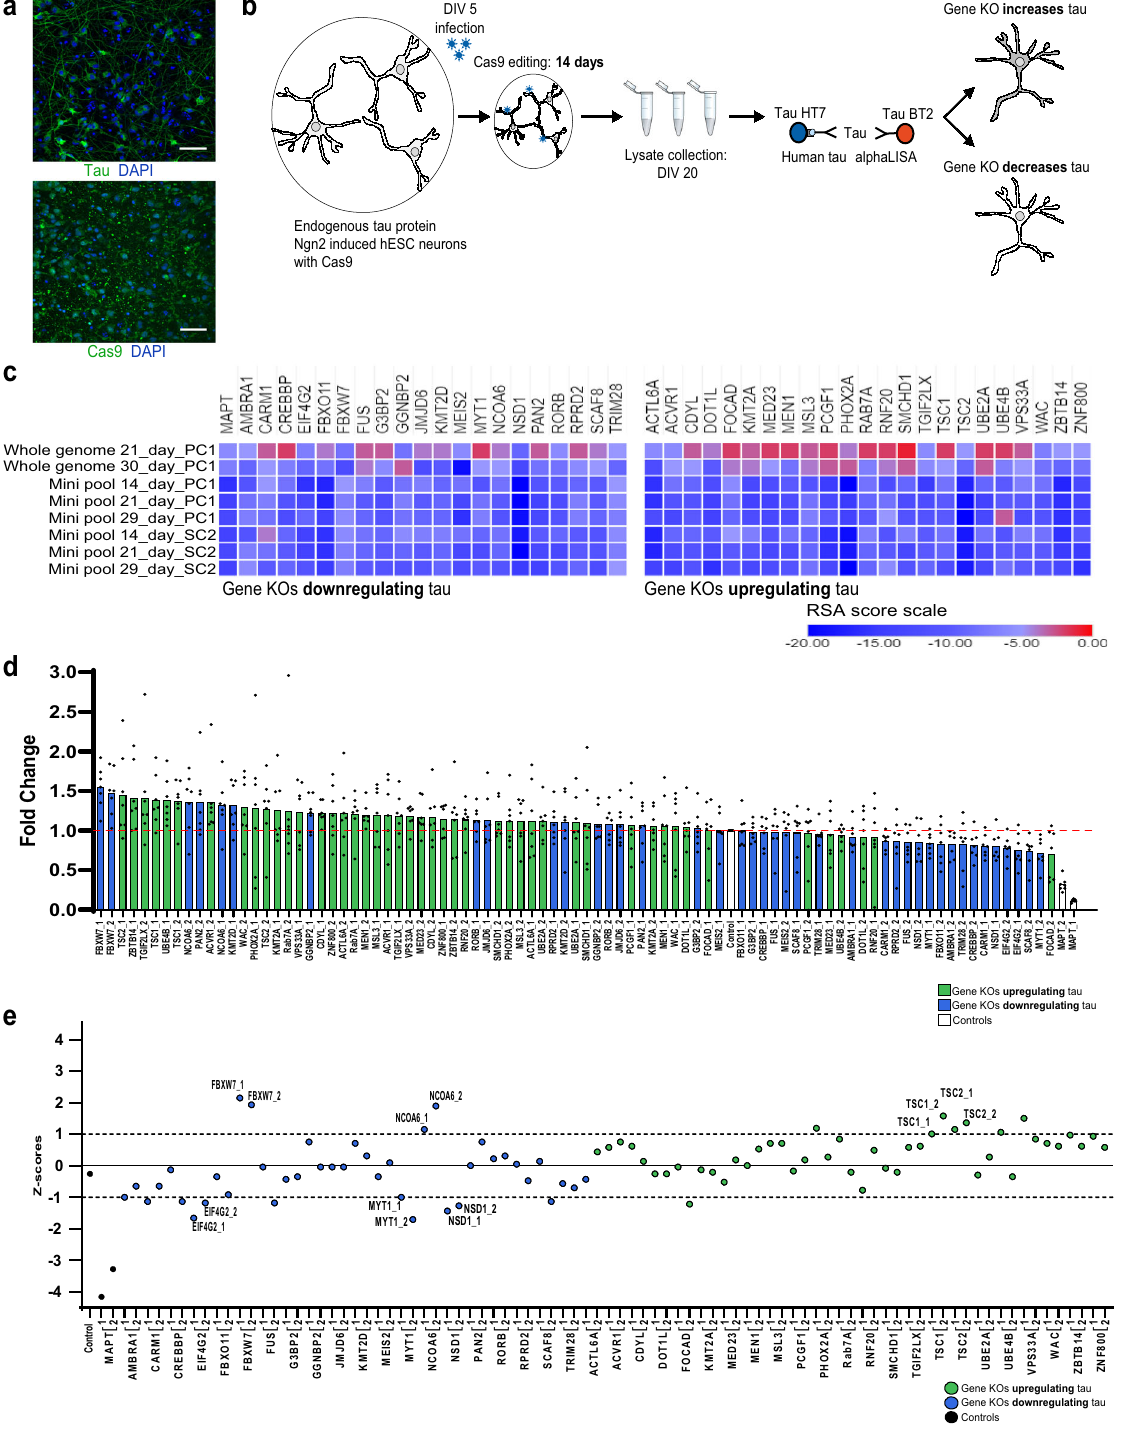
Fig. 3 Candidate genes validated in a human neurons. a Immunocytochemistry of endogenous tau (SP70) and Cas9 in iNgn2 neuronal cultures 14 days of post-differentiation. Scale bar represents 1000 µ m. b Schematic representation of secondary well-based screen in human neurons. c Heat maps showing top 44 genes candidate genes with an RSA score ≤ − 5.0. Twenty-one downregulating genes (left) and 23 upregulating genes (right). d Quantitative analysis of tau protein levels in neurons following treatment with individual gRNAs. Gene knockouts downregulating tau (blue) and gene knockouts upregulating tau (green). Data is represented as fold change of tau protein levels compared to non-targeting control gRNAs ± SEM for seven biological replicates. e Z -score analysis on fold change for individually tested gRNAs, for gene knockouts downregulating tau (blue) or gene knockouts upregulating tau (green). Validated genes 1 standard deviation above or below the mean are labeled. KO knockout, DIV days in vitro, hESC human embryonic stem cells, Control is a non-target